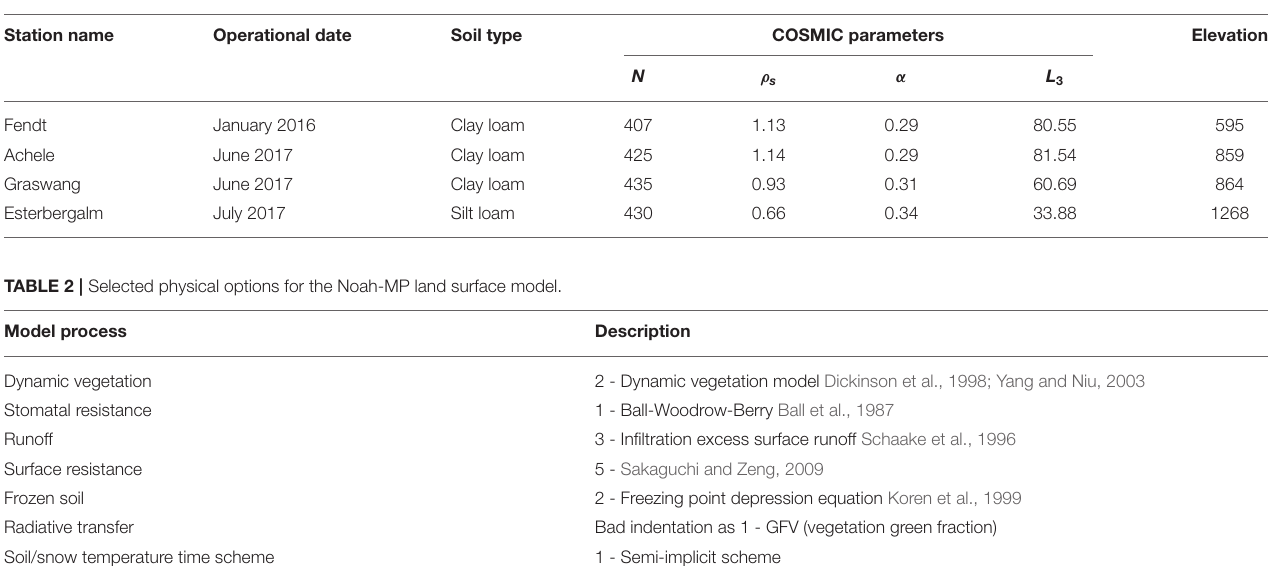
TABLE 1 | CRNS station information on operational month, soil type, elevation (m.a.s.l.), and parameters used in the COSMIC forward operator, background cosmic radiation N (-), soil bulk density ρ s (g/cm 3 ), efficiency of fast neutron creation α (-), and shape parameter L 3 (g/cm 3 ).